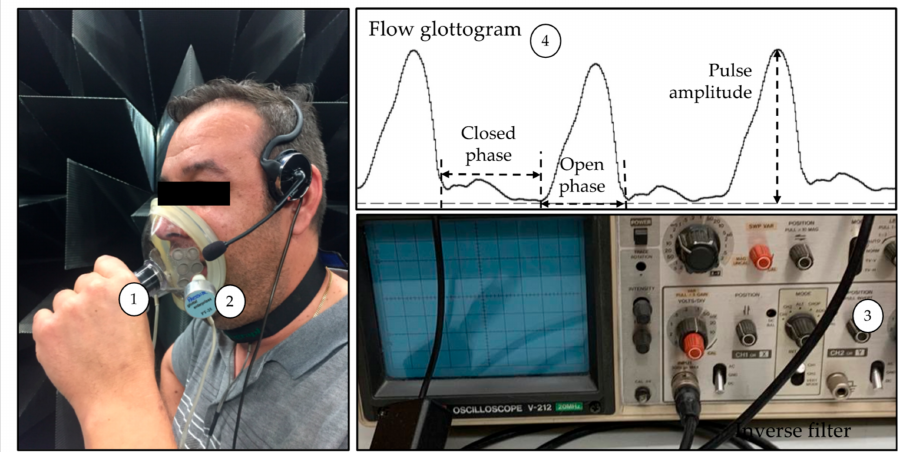
Figure 13. Left panel: (1) a flow mask with a (2) pressure transducer. Its output can be connected to